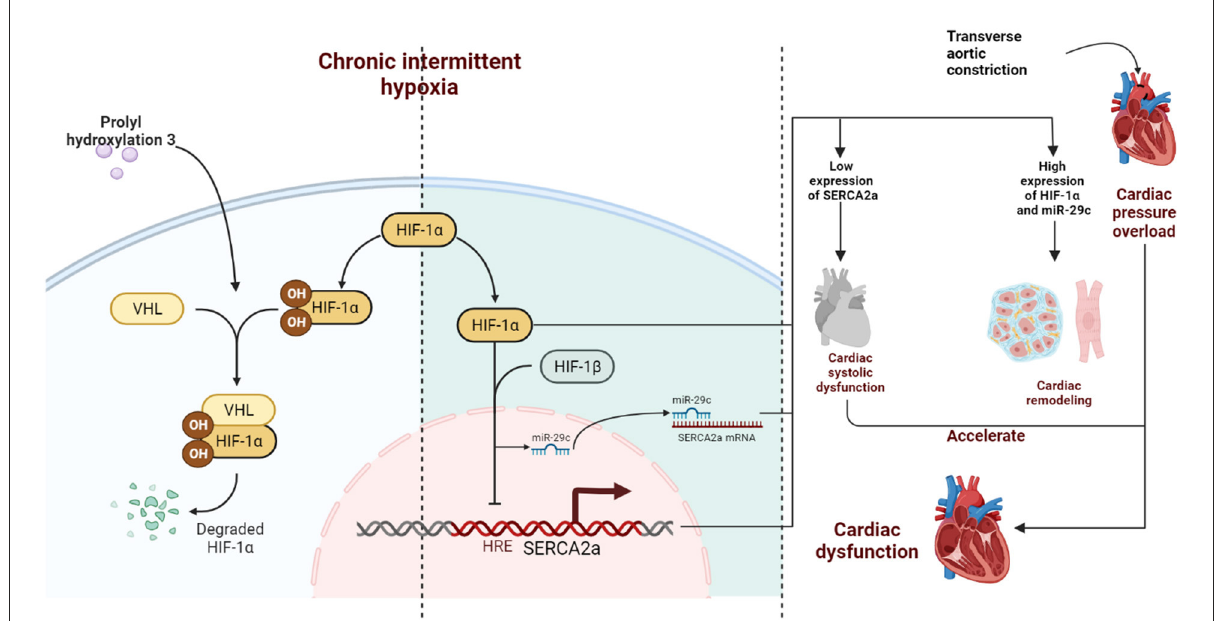
FIGURE7 Schematic diagram. CIH exposure promotes long-term abnormalities in the expression of HIF-1 α in mice subjected to TAC, further inducing continuous upregulation of miR-29c expression. Together, HIF-1 α and miR-29c inhibit the expression of SERCA2a in the nucleus and cytoplasm in cardiomyocytes accelerating left ventricular systolic dysfunction. In addition, HIF-1 α promotes cardiac remodeling, which ultimately synergistically accelerates cardiac dysfunction. PHD3 overexpression in the heart during CIH can lead to degradation of HIF-1 α in a timely manner and reduce cardiac damage caused by CIH